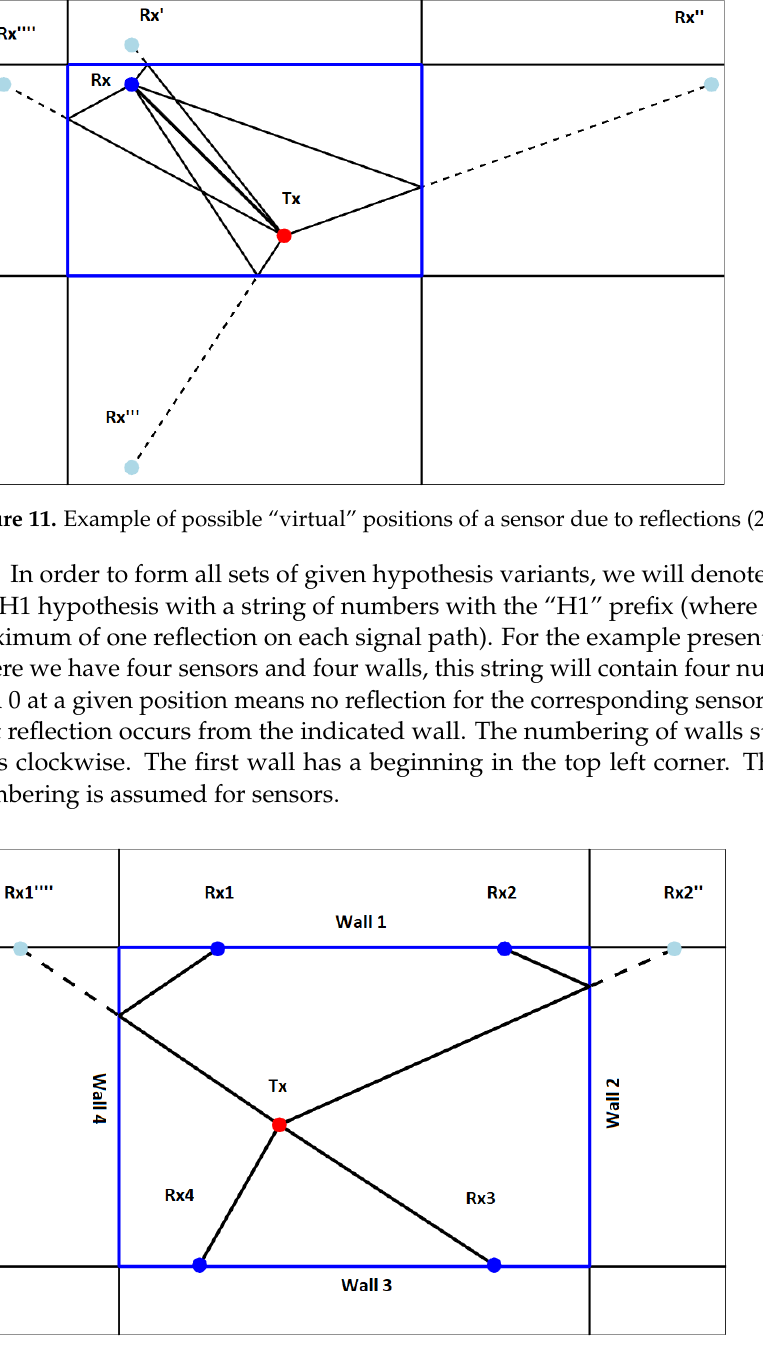
Figure 12. Example of handling the variant H1-4200 of reflection hypothesis